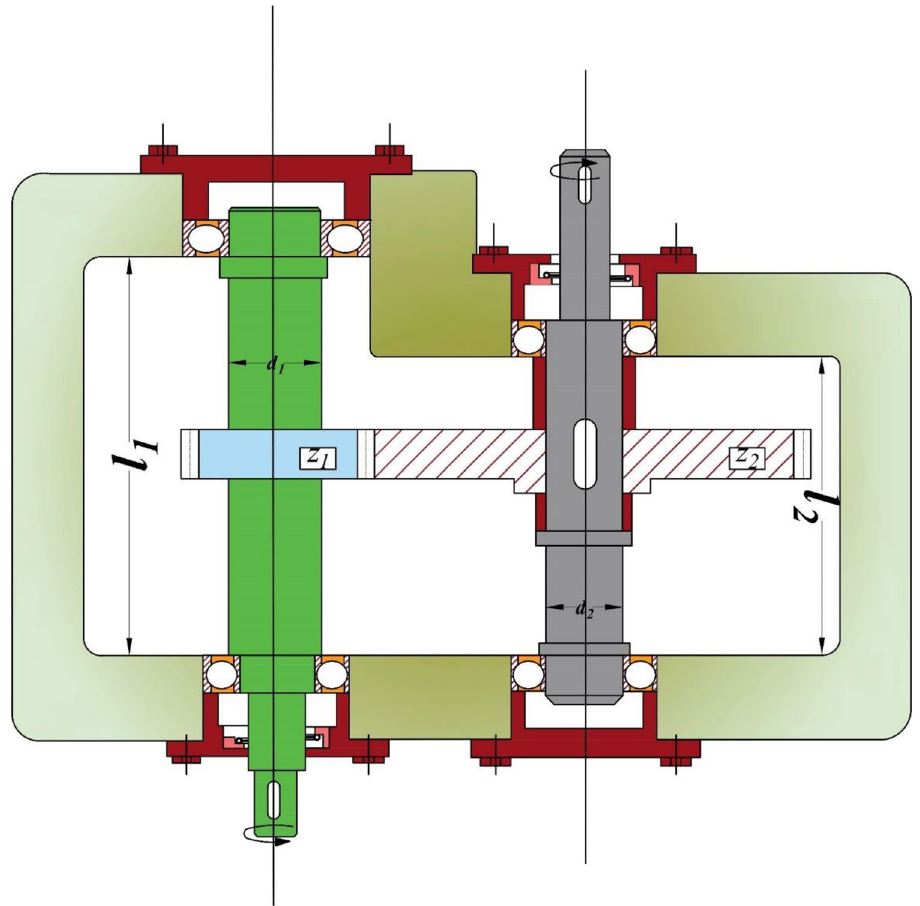
Figure 5. Schematic representation of the speed reducer problem.